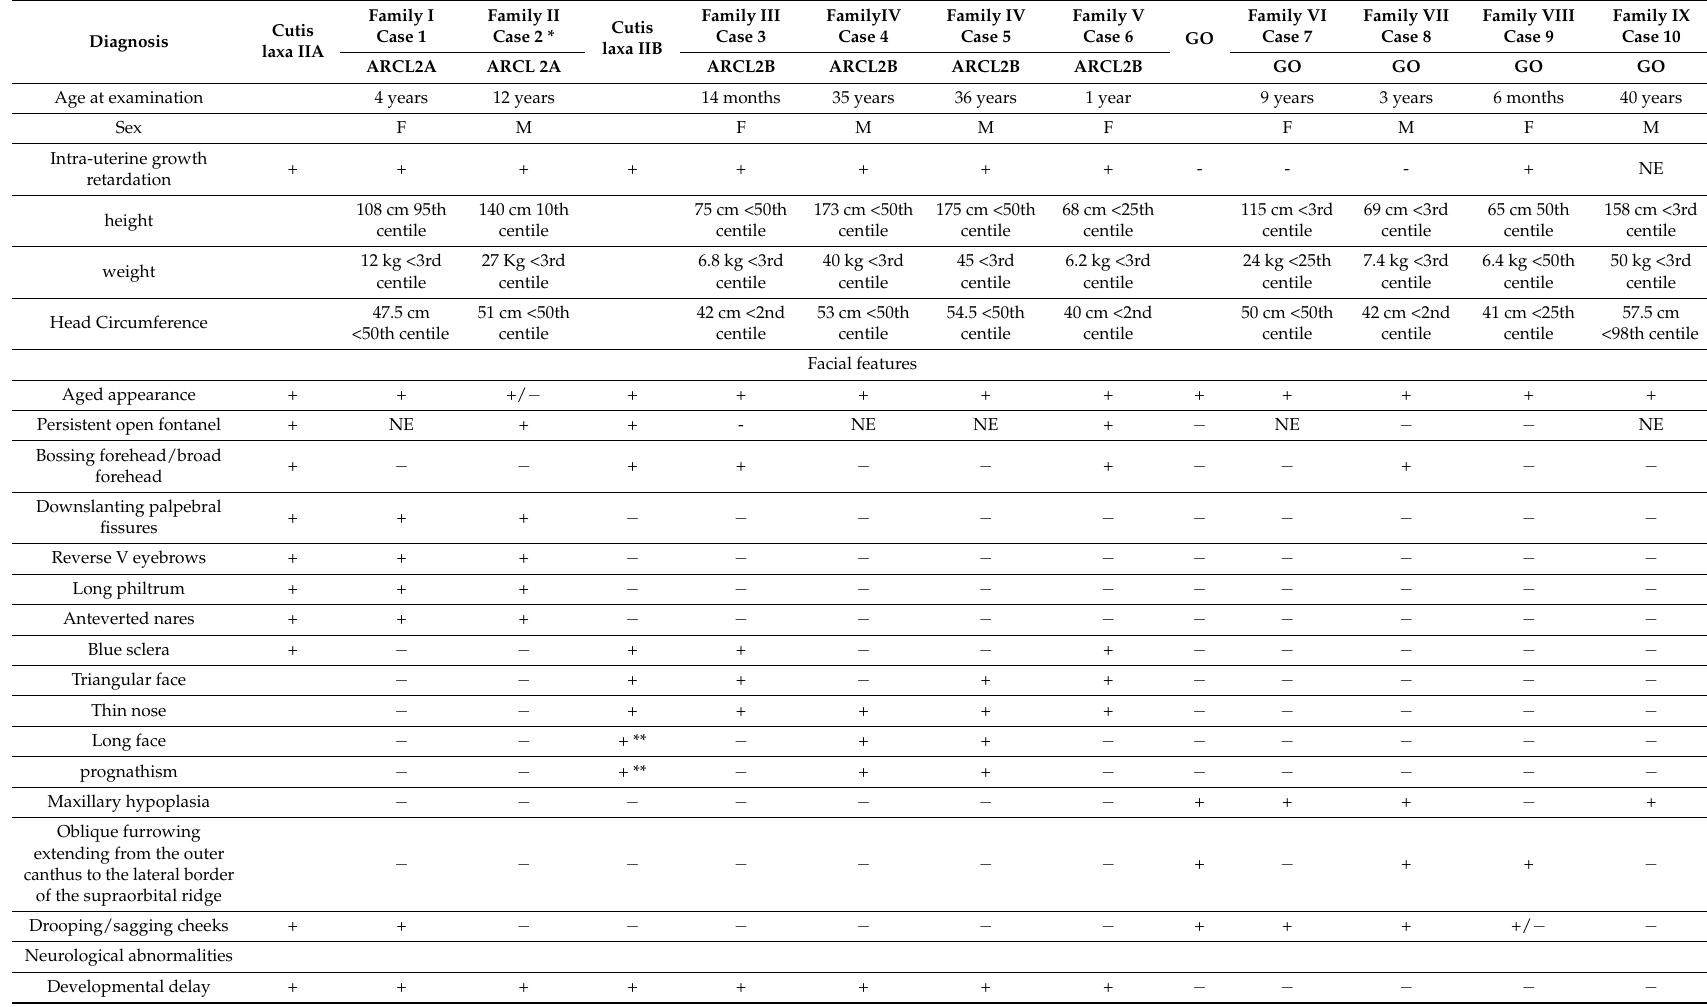
Table 1. Comparison of clinical features of cutis laxa IIA, IIB, and GO syndrome, and 10 patients with these cutis laxa